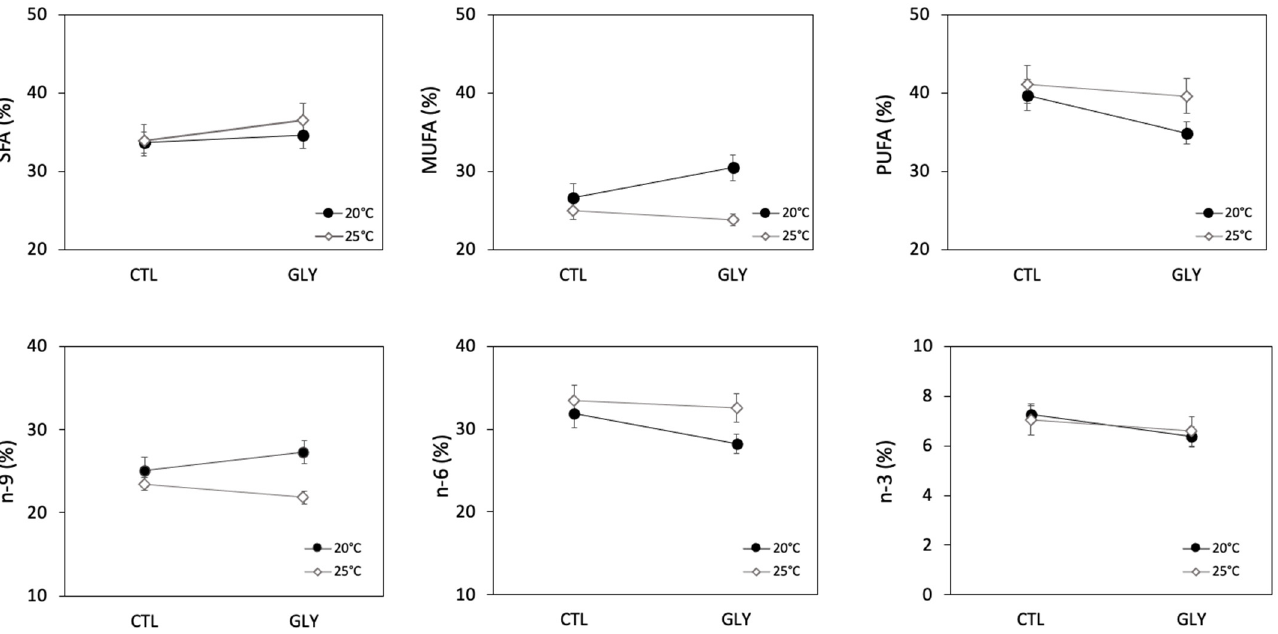
Figure 4. Fatty acid groups in snails ( Lymneae sp.) among different exposure conditions in the control group (CTL) and glyphosate-exposed group (GLY) at 20 °C and 25 °C. Values are shown as % mean ± SEM for each condition (n = 6, two snails per triplicated conditions). Saturated Fatty Acids (SFA), Monounsaturated Fatty Acids (MUFA), Polyunsaturated Fatty Acids (PUFA), omega − 9 (n-9), omega-6 (n-6), omega-3 (n-3). Table 2. Fatty acid composition in snails ( Lymneae sp.) in control group (CTL) and glyphosate-exposed group (GLY) at 20 and 25 ◦ C. Values are shown as % mean ± SEM (n = 6) for each condition. Significant results from the two-way ANOVA are presented with * p < 0.1; ** p < 0.05; *** p < 0.005. Glyphosate (GLY), temperature (TEMP), glyphosate*temperature interaction